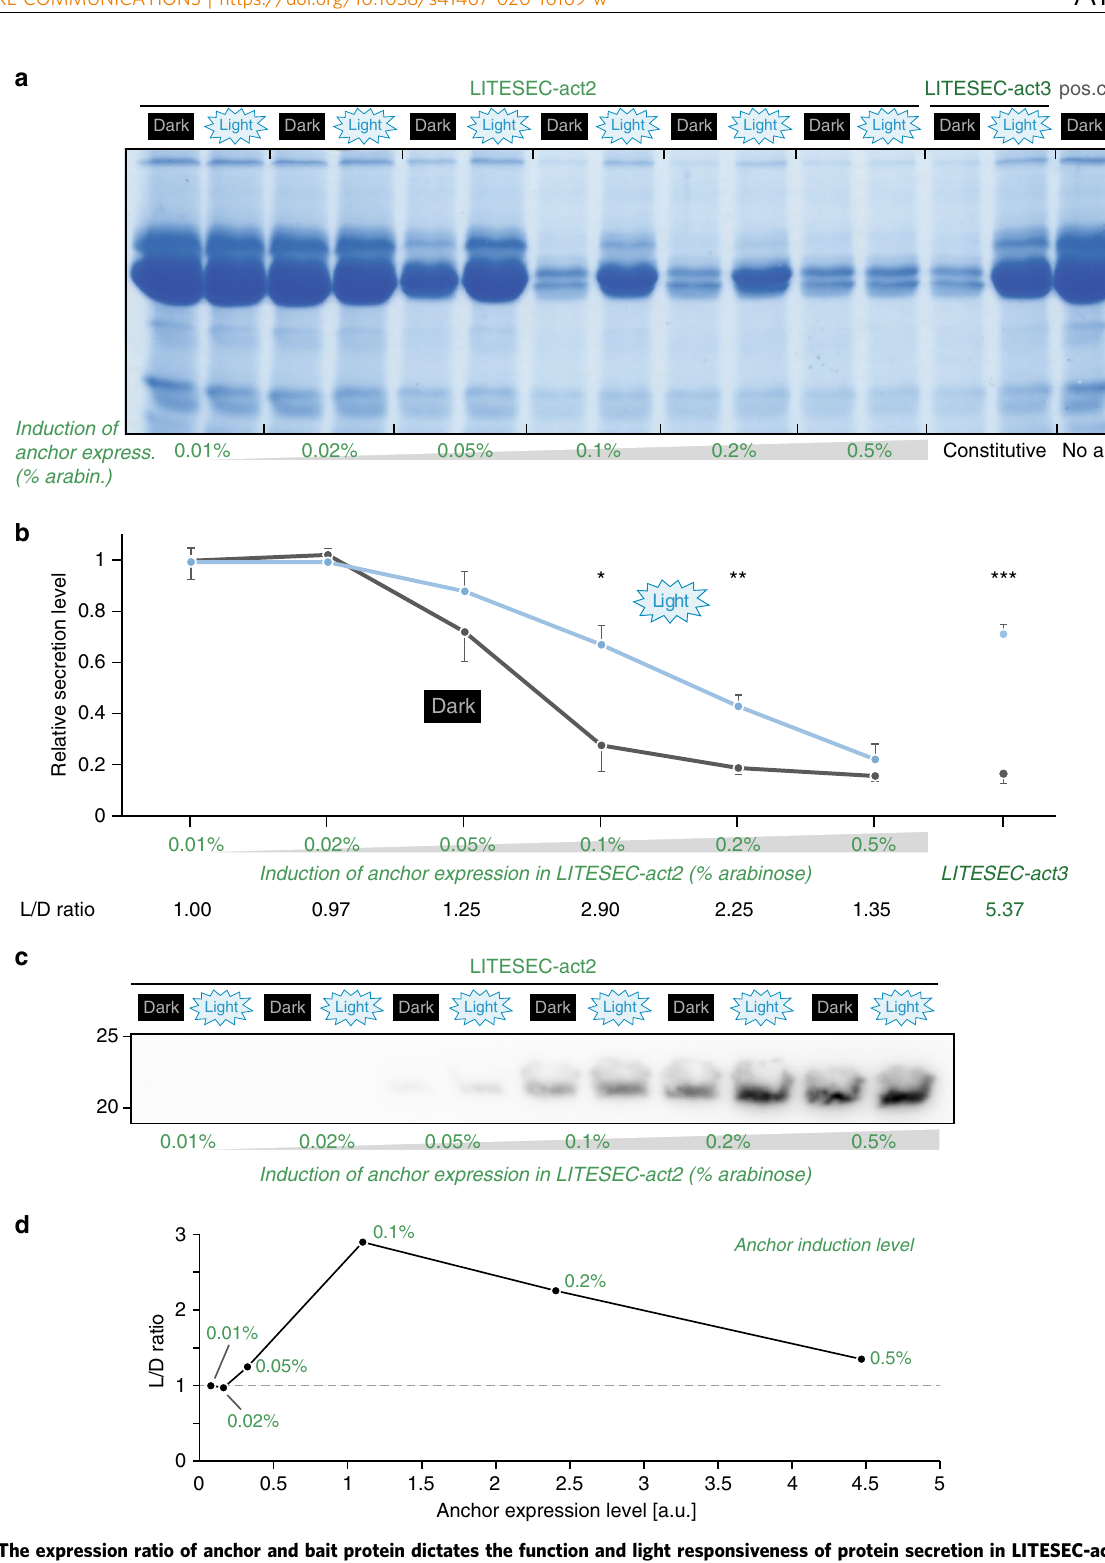
Fig. 5 The expression ratio of anchor and bait protein dictates the function and light responsiveness of protein secretion in LITESEC-act2. a In vitro secretion assay showing light-dependent export of native T3SS substrates in the LITESEC-act2 strain at different induction levels of anchor expression. For protein assignment and molecular weight, see Fig. 4a. b Quanti fi cation of secretion ef fi ciency and light/dark secretion ratio (L/D ratio) for the different expression levels indicated above (as in ( a )). N = 3 gel densitometry values from independent experiments for LITESEC-act2 induced with 0.02 or 0.2% arabinose and LITESEC-act3; N = 4 for all other conditions; error bars display standard error of the mean. */**/*** p < 0.05/0.01/0.001 in a two-tailed homoscedastic t test (exact values from left to right, 0.95/0.67/0.24/0.012/0.009/0.29/3 × 10 − 5 ). c Western blot anti-FLAG of total cellular protein of 2 × 10 8 bacteria in the LITESEC-act2 strain at the indicated induction levels and conditions. Left side, molecular weight in kDa. See Supplementary Fig. 6 for corresponding Ponceau staining as a loading control. d Correlation between light/dark secretion ratio (L/D ratio) as determined in ( b ) and anchor expression level. Labels indicate anchor induction levels (arabinose concentrations for LITESEC-act2); the gray dashed line denotes an L/D ratio of 1, indicating light-independent secretion. Source data for panels ( b − d ) are provided as a Source Data